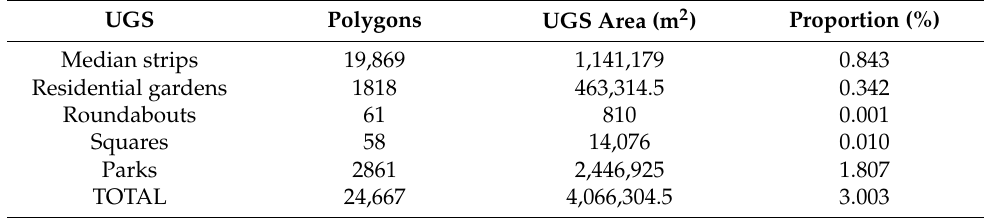
Table 2. Results of the homogenization of UGS